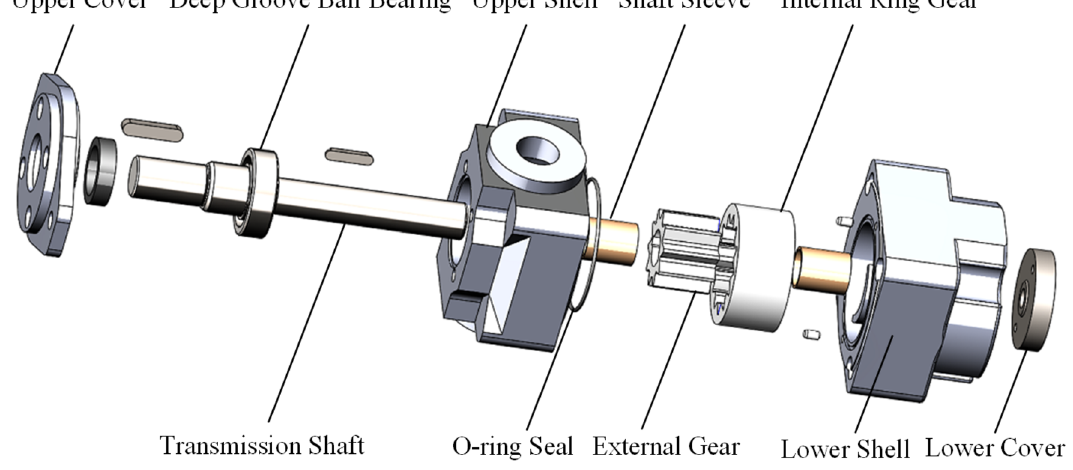
Figure 1. Structure of a Truninger